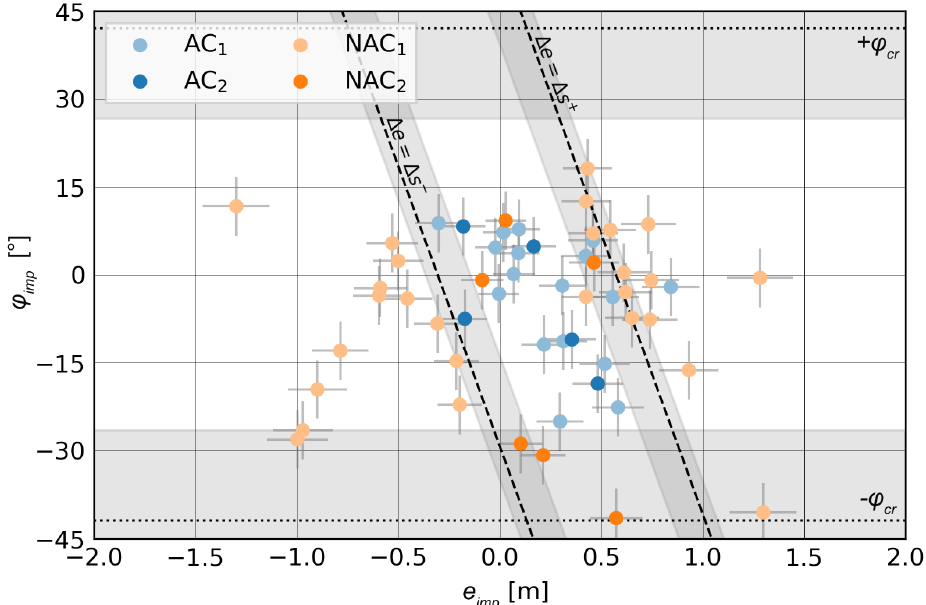
Figure 15. Comparison of the measured log orientation ( ϕ imp and e imp ) with the accumulation criterion ∆ s − ≤ ∆ e ≤ ∆ s + . A total of 95% of the observed accumulated logs (AC 1 and AC 2 ) lie within the predicted range, while 89% of the NAC 1 logs lie outside the range. The n = 6 NAC 2 logs are poorly predicted by the criterion. The criterion was evaluated with µ = 0.9 and the gray areas reflect the uncertainty in µ ranging from 0.5 to 1.1 [26]. Error bars of ± 0.05 e imp + 0.1m (position accuracy of P3) for e imp and ± 5° for ϕ imp are plotted in